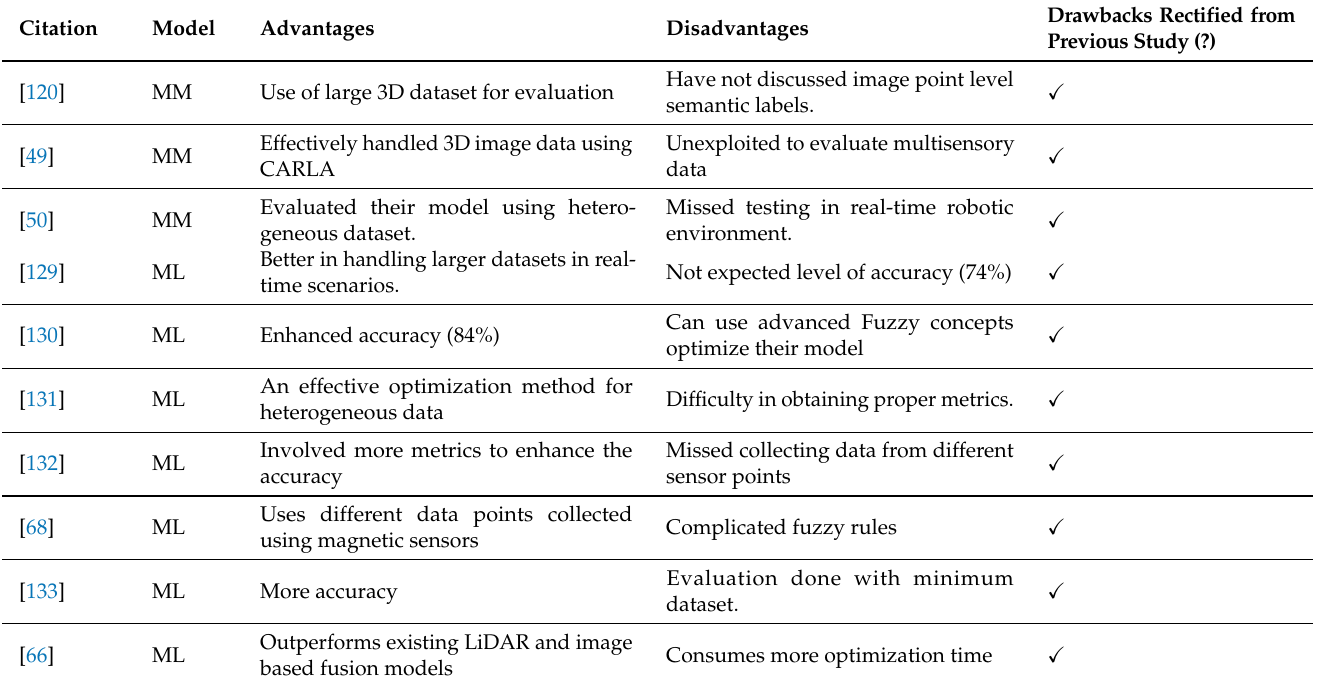
Table 5. Chronological summary of various fusion methods (ML—machine learning, MM—mathe- matical